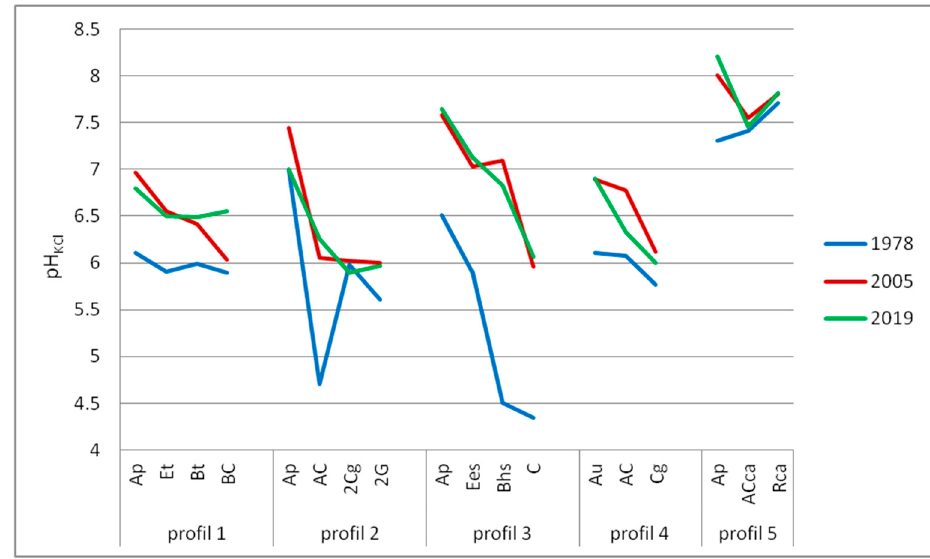
Figure 4. Dynamics of pH KCl value ranges in individual horizons of the analysed soils between 1978 and 2019.